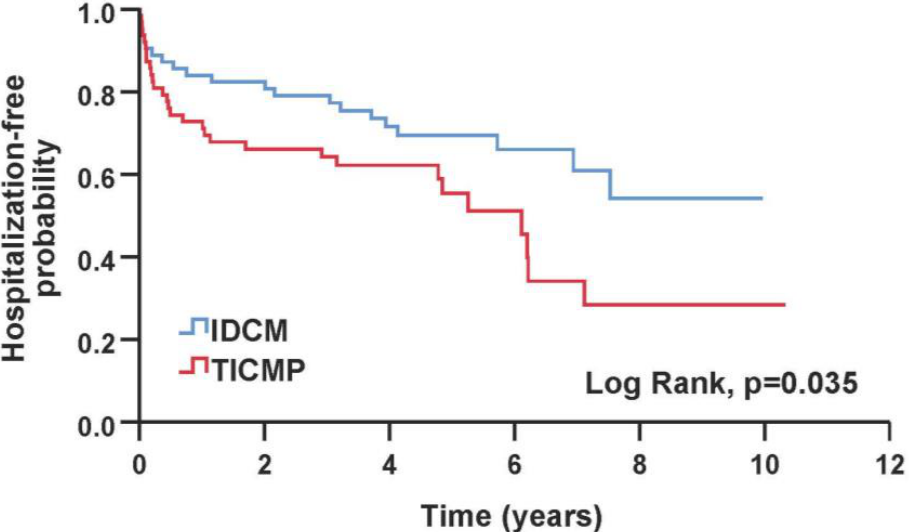
Figure 4. Kaplan–Meier survival probabilities for patients admitted for a first heart failure hospital- ization. IDCM—idiopathic dilated cardiomyopathy; TICMP—tachycardia-induced cardiomyopa-